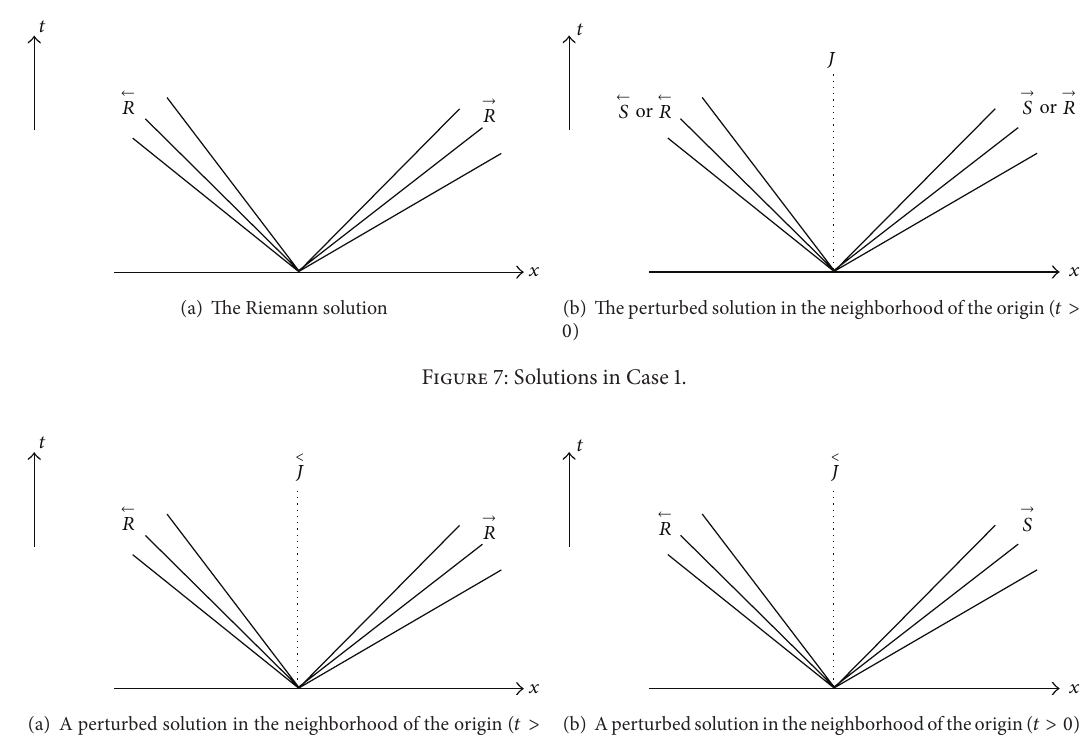
Figure 8: Solutions in Case